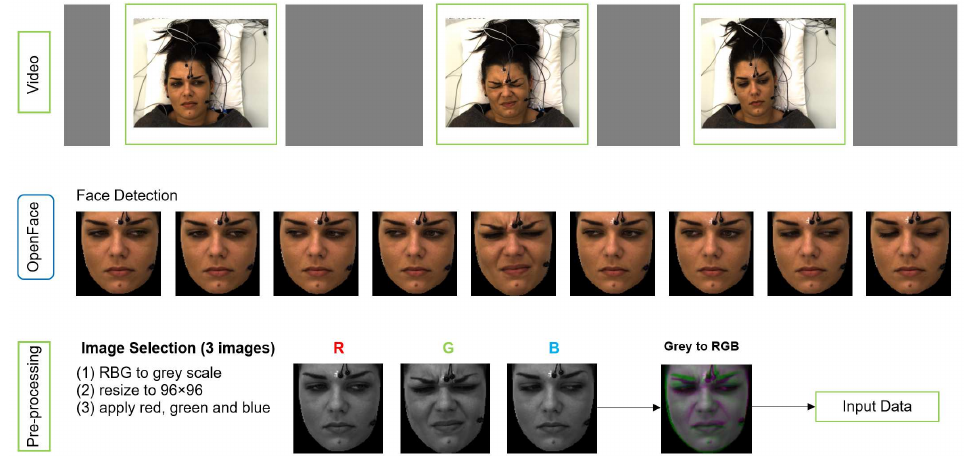
Figure 4. The pipeline of data preparation